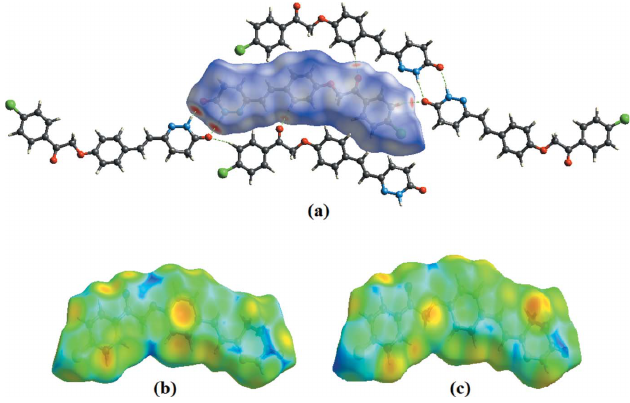
Figure 2 ( a ) A view of the crystal packing of the title compound along the c axis. Dashed lines indicate hydrogen bonds. ( b ) C—H (cid:3)(cid:3)(cid:3) (cid:2) interactions. ( c ) A view of the molecular stacks running along the a axis.